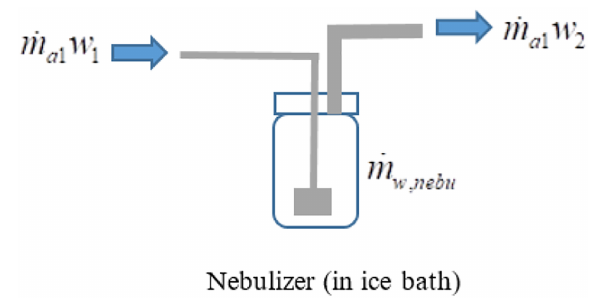
FIGURE 2 | Mass balance of water vapor in the virus nebulizer. The inlet water vapor content plus the water vapor content generated in the nebulizer (from the virus inoculum) is equal to the water vapor content exiting the